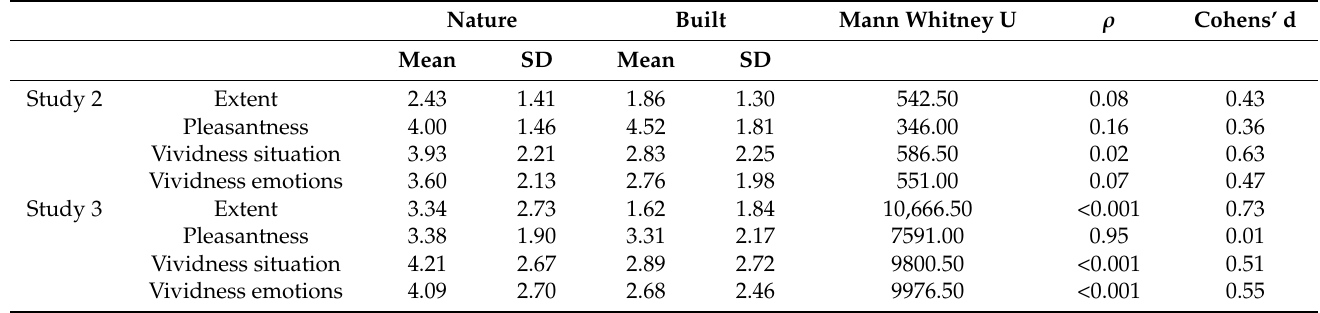
Table A3. Descriptive and Test Statistics for the Additonal Outcome